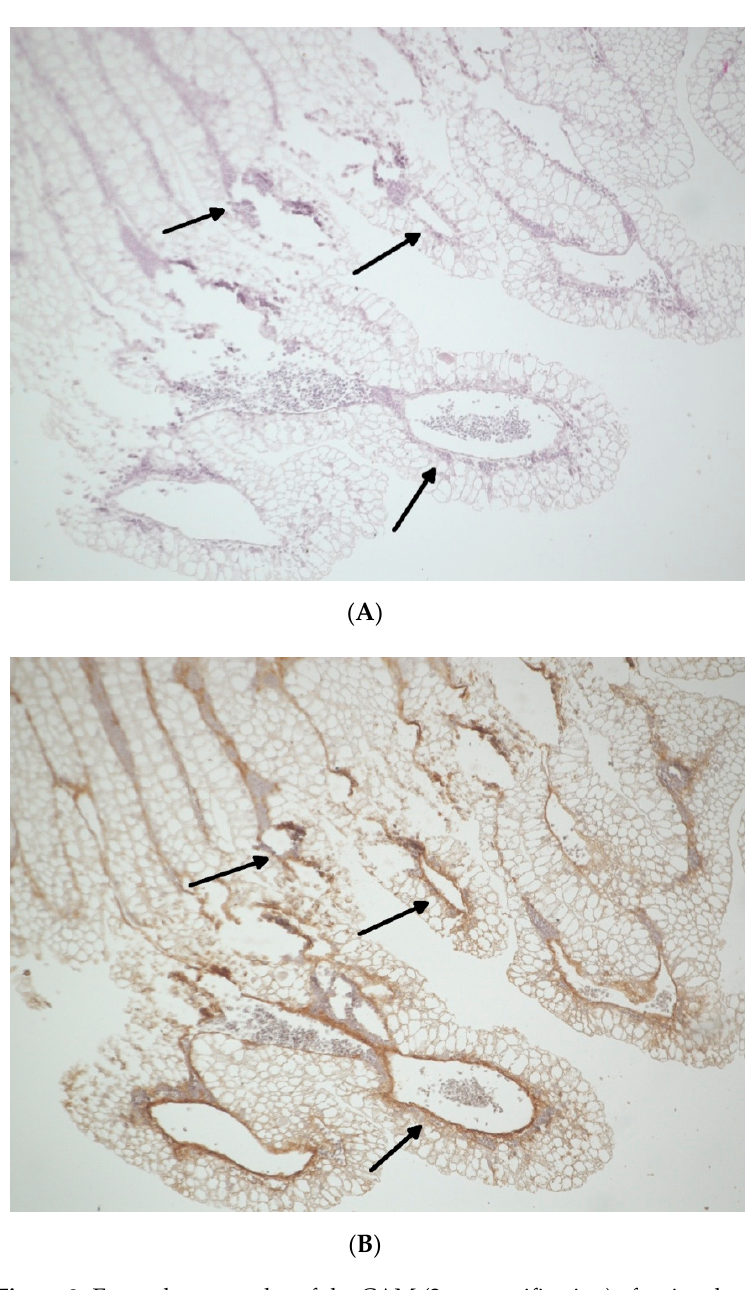
Figure 2 . Exemplary samples of the CAM (2 × magnification) after incubation of allogeneic BSMs with platelet-rich fibrin (PRF) for 24 h displayed immunohistochemically via hematoxylin–eosin (HE) ( A ) and smooth muscle actin (SMA) ( B ) antibodies. Arrows indicate vessel formation.